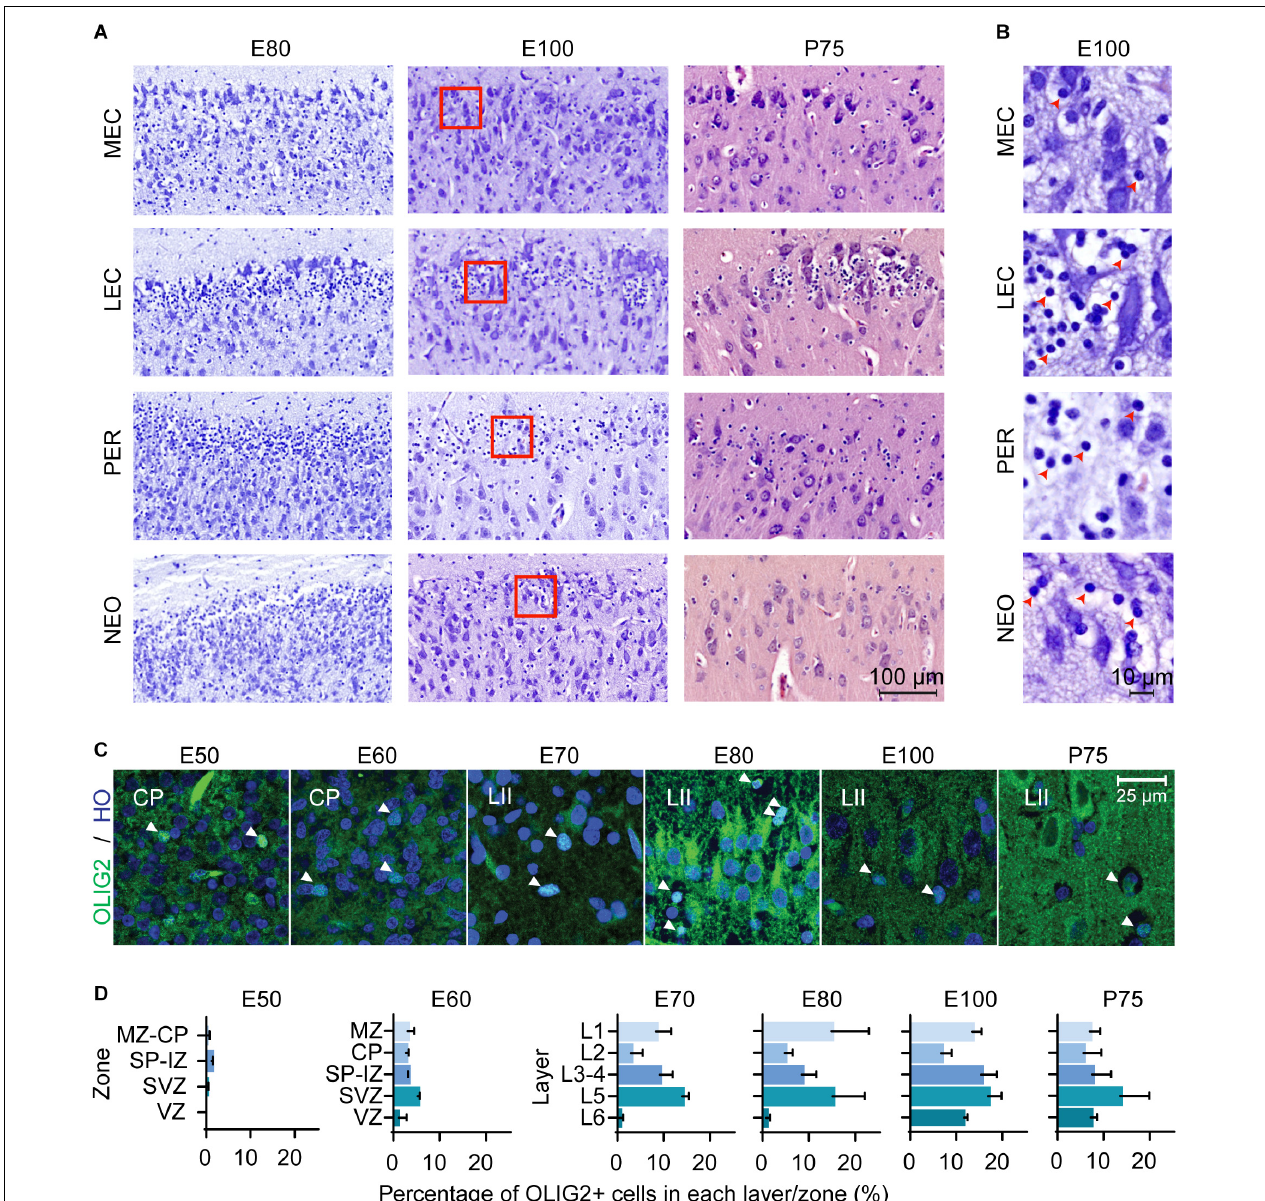
FIGURE 2 | Oligodendrocyte precursor cells (OPCs) emerge in the entorhinal cortex (EC) early in the second trimester. (A) A high number of OPCs are present in the superficial layers of the lateral entorhinal cortex (LEC) and perhirhinal cortex (PER) and less OPCs observed in the medial entorhinal cortex (MEC) and neocortex (NEO) at different Embryonic days (E) and at Postnatal day (P) 75. Scale bar 100 µ m. (B) High magnification of red squares in (A) depicts the morphology of the OPCs at E100 which shows condensed nuclei and nissl free cytoplasm (red arrowheads). Scale bar 10 µ m. (C) OLIG2 expression and Hoescht (HO) staining in the developing EC. Images taken within the developing cortical plate (CP) (E50-E60) and later (E70-P75), in Layer II (LII). Scale bar 25 µ m. (D) Quantification of OLIG2 positive cells in the EC by zones/cortical layers from E50 until P75. Cortical plate, CP; intermediate zone, IZ; marginal zone, MZ; subplate, SP; subventricular zone, SVZ ventricular zone, VZ. All error bars represent